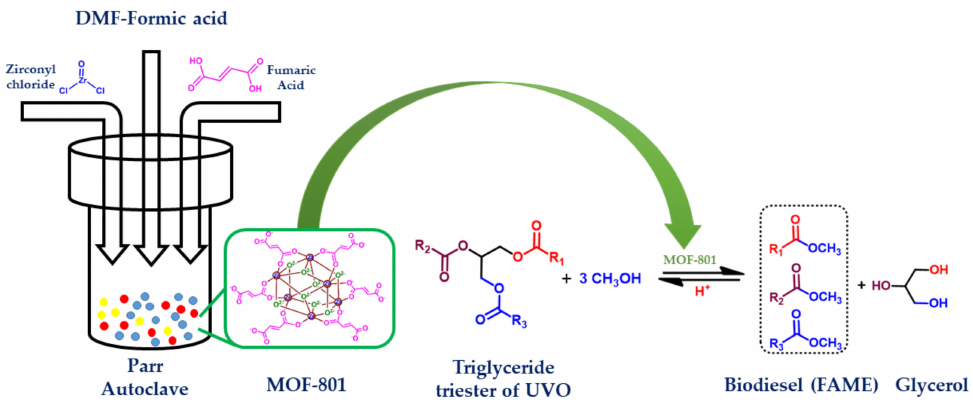
Scheme 1. Graphical representation of t transesterification of UVO to biodiesel utilizing the synthe- sized fumarate-based MOFs (MOF-801)